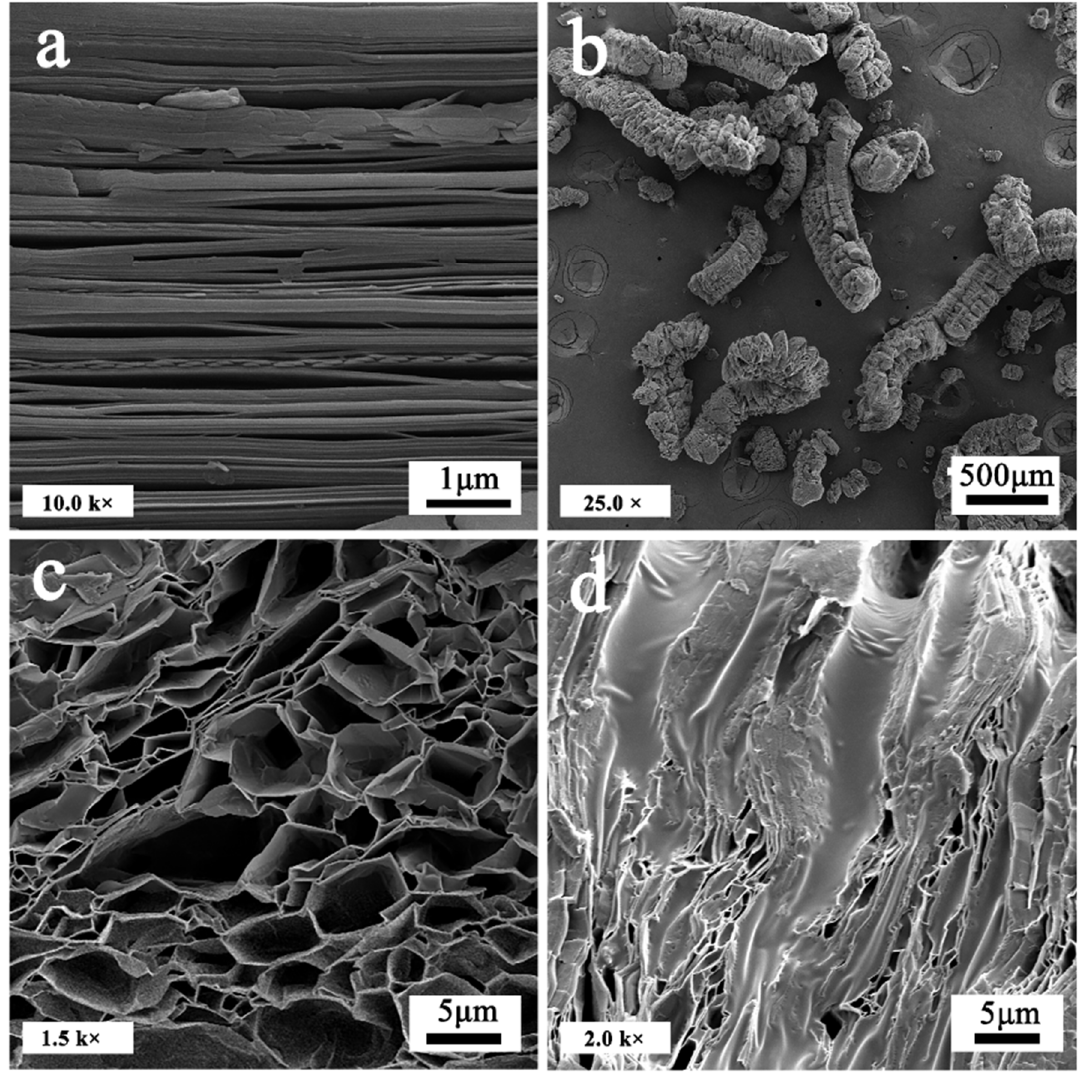
Figure 3. ( a ) SEM images of expandable graphite; ( b ) worm-like expanded graphite; ( c ) micropores of expanded graphite; ( d ) SD/E.